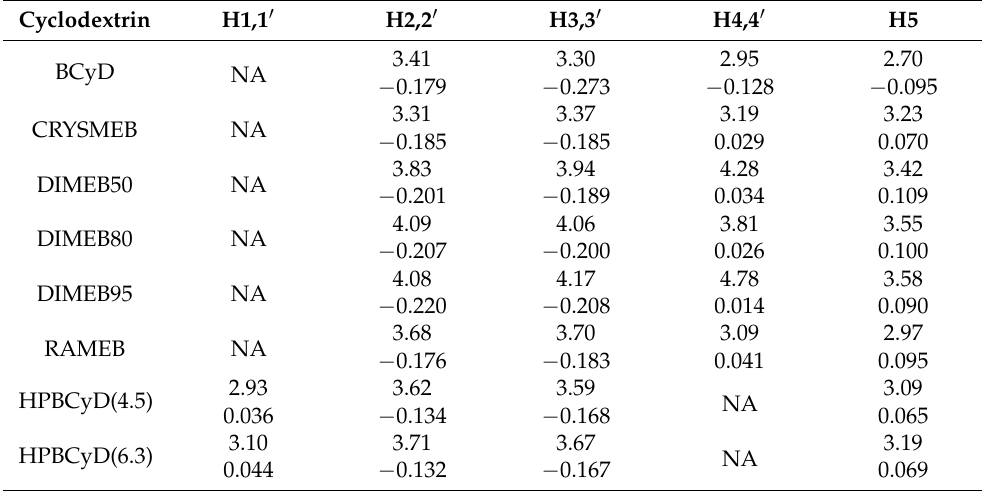
Table 3. The complex stability constants of CyD-fenbufen complexes (every odd line) followed by the maximal chemical shift response (every even line) obtained from regression fits performed on the data of each individual NMR peak for CyD-fenbufen complexes. The uncertainty of chemical shift response values (on ppm scale) is on the order of 0.001.